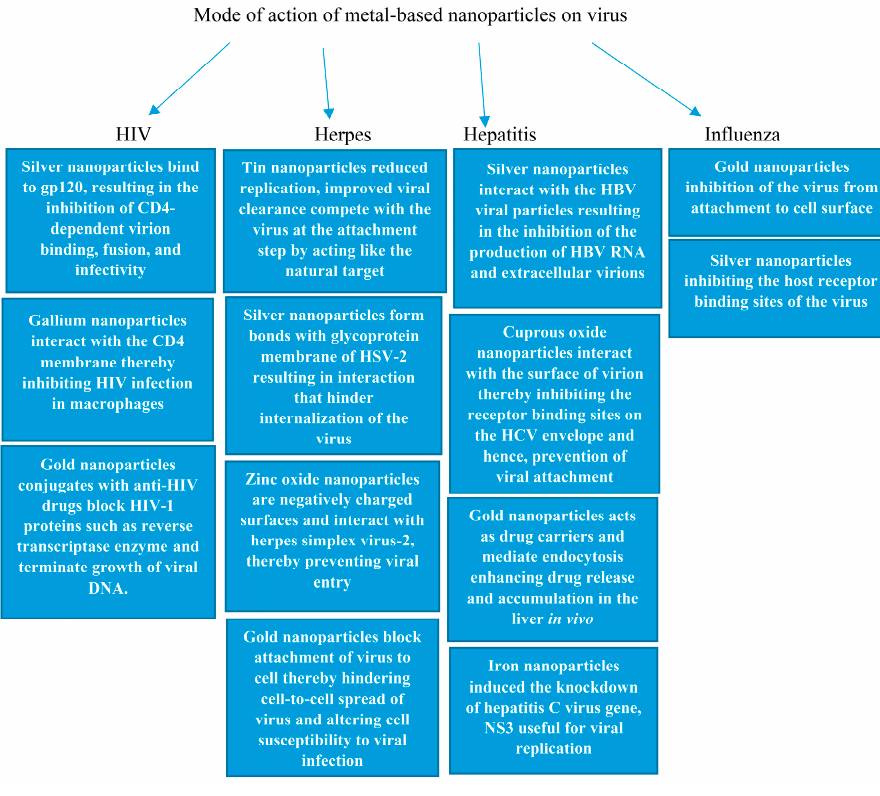
Figure 5. Mode of action of nanoparticles on viruses.